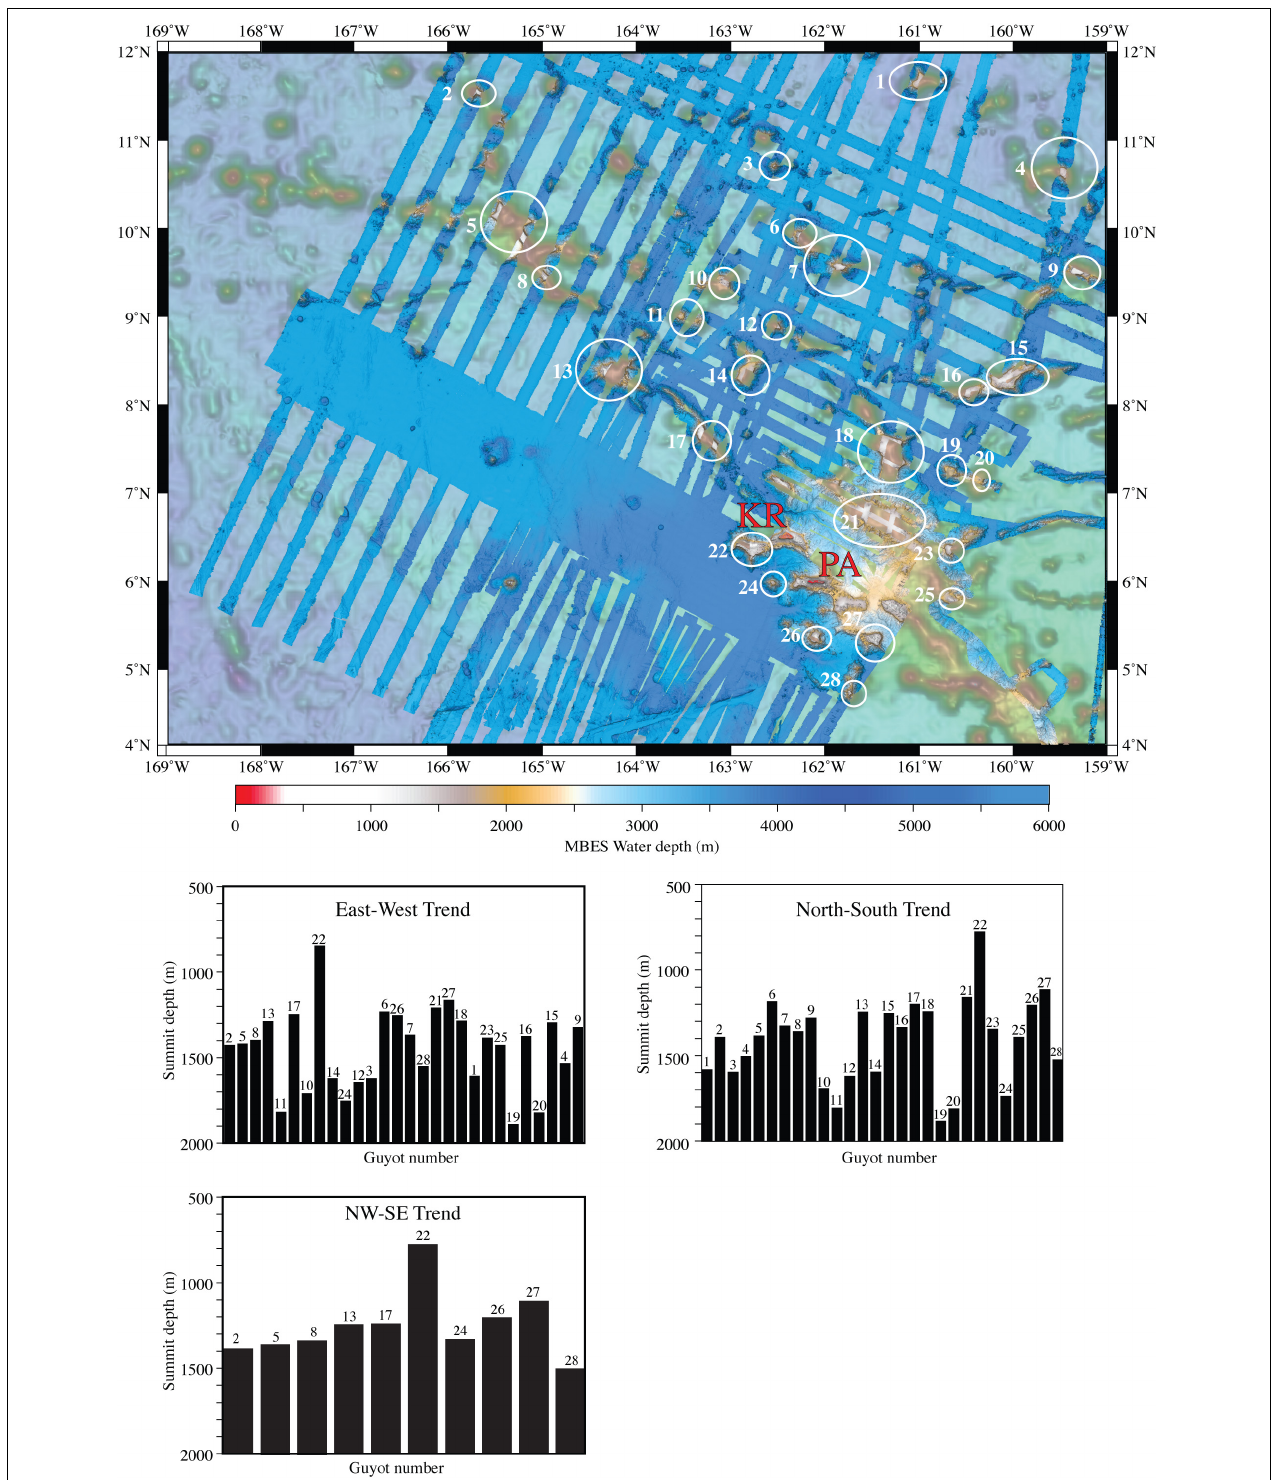
FIGURE 14 | Map view of locations of guyots mapped from multibeam bathymetry within the northern Line Islands Ridge. KR is Kingman Reef and PA is Palmyra Atoll. Guyot numbers on map view are shown on the three histograms below map. The histograms show the guyot summit depth versus guyot in an E-W, N-W and NW-SE directions. Background bathymetry GMRT (Ryan et al.,